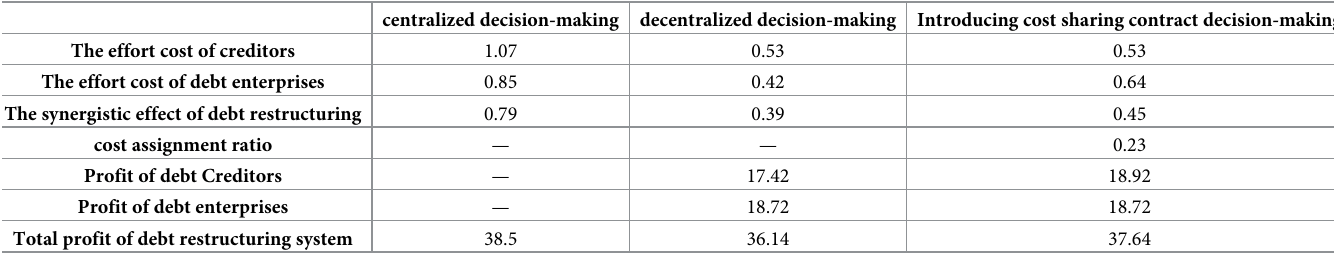
Table 2. Differential game equilibrium results under different decisions.